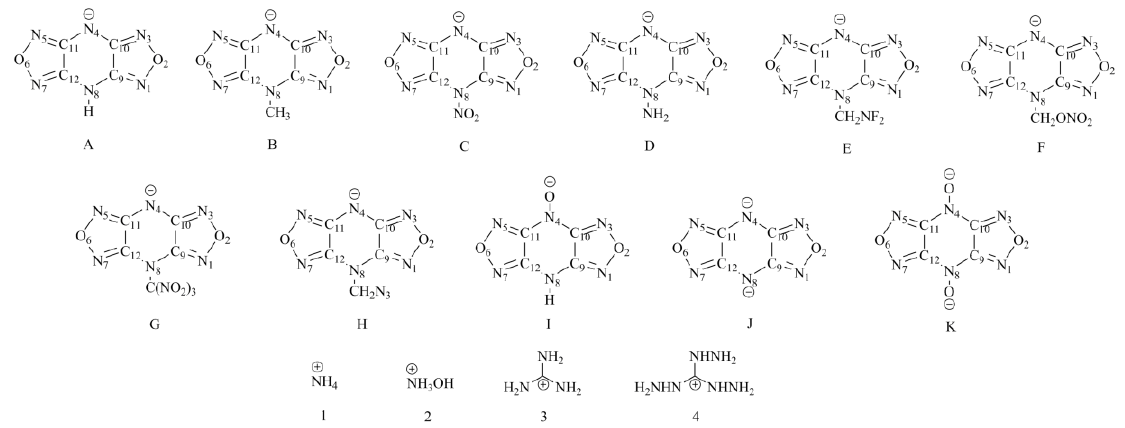
Figure 1. Frameworks of ammonium-based 4,8-dihydrodifurazano[3,4- b , e ]pyrazine-based salts.